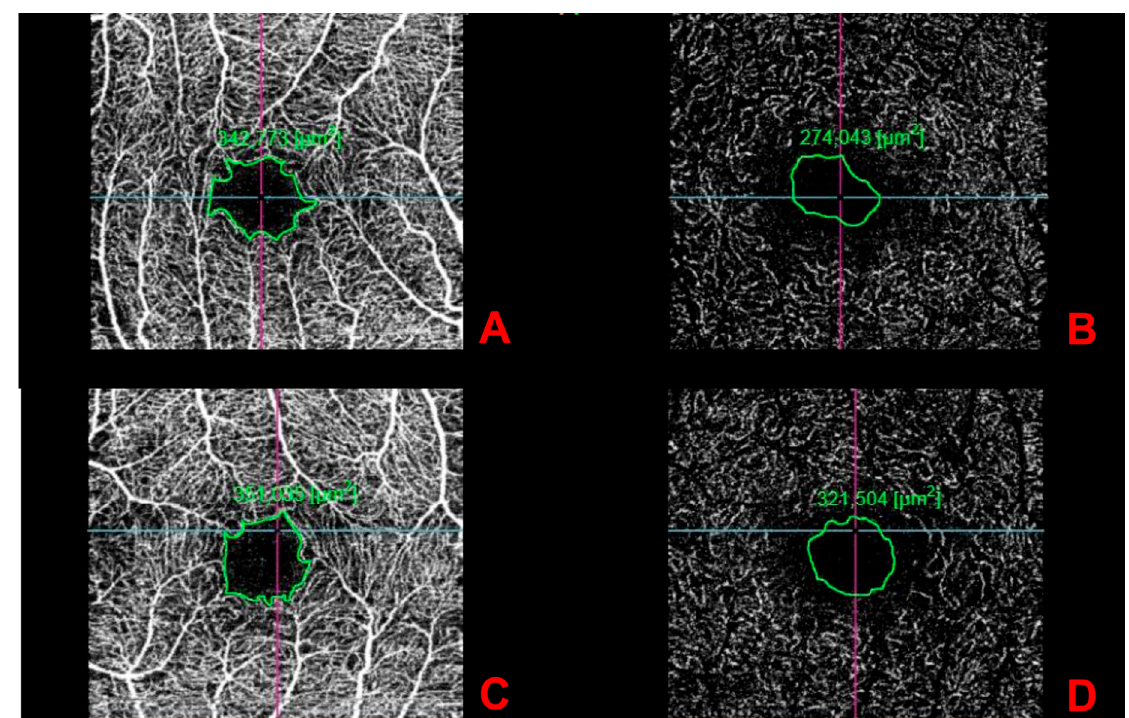
Figure 4. Foveal avascular zone enlargement in optical coherence tomography angiography images of the superficial and deep layers ( A , B ) right eye; ( C , D ) left eye).